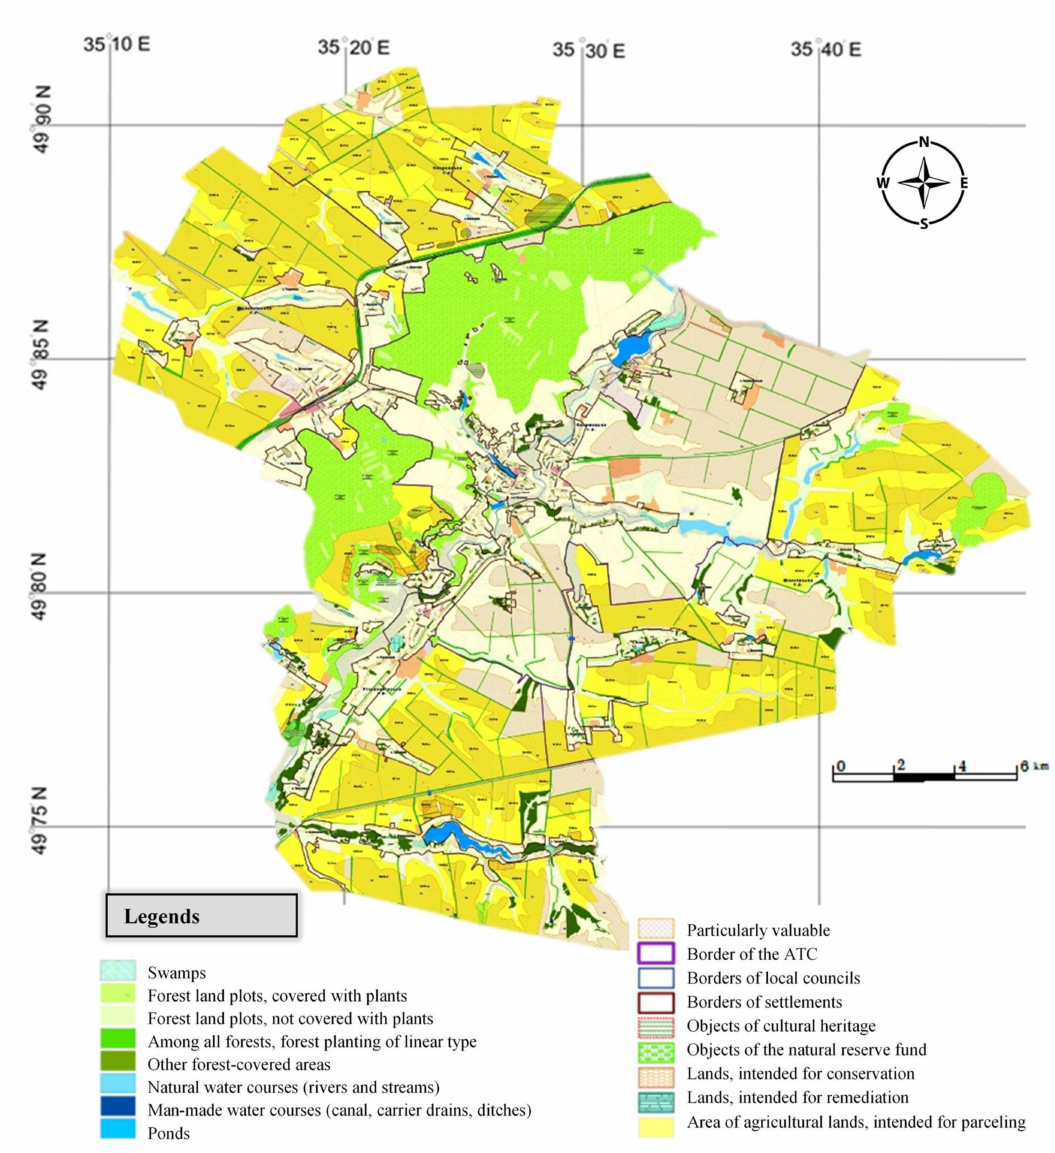
Figure 3. Scheme of the planned measures on rational use and protection of lands of Kolomak amalgamated territorial community. Basemap source: Open e-Maps